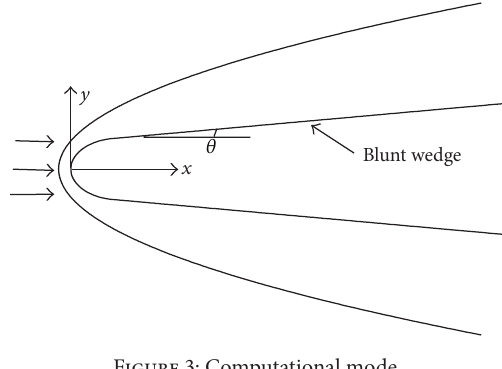
Figure 3: Computational